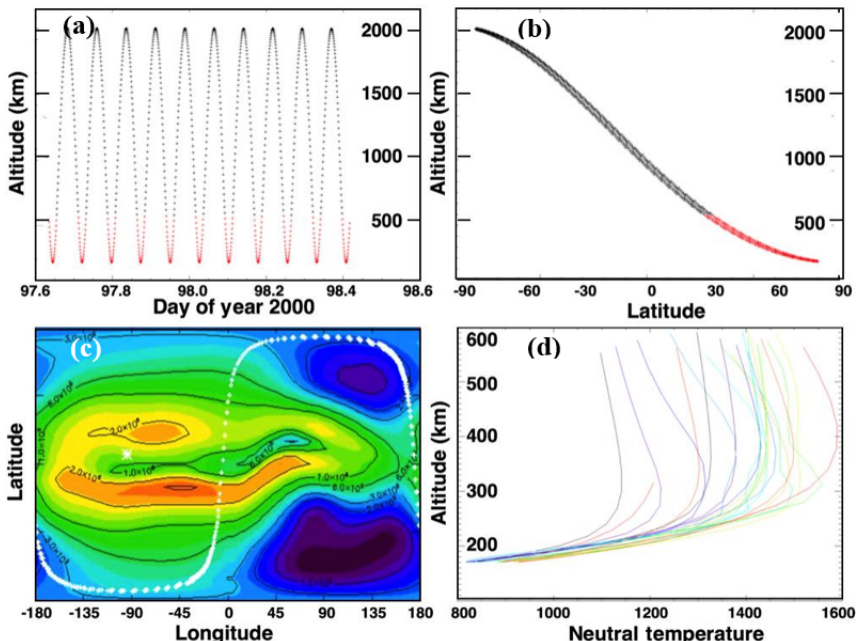
Figure 14. (a) Altitude vs. time for 10 Daedalus orbits; (b) altitude vs. latitude. Red dots: measurements below 500km. (c) Horizontal sampling and (d) vertical sampling of neutral temperature from NRLMSISE along 10 consecutive orbits during the April 2000 storm.